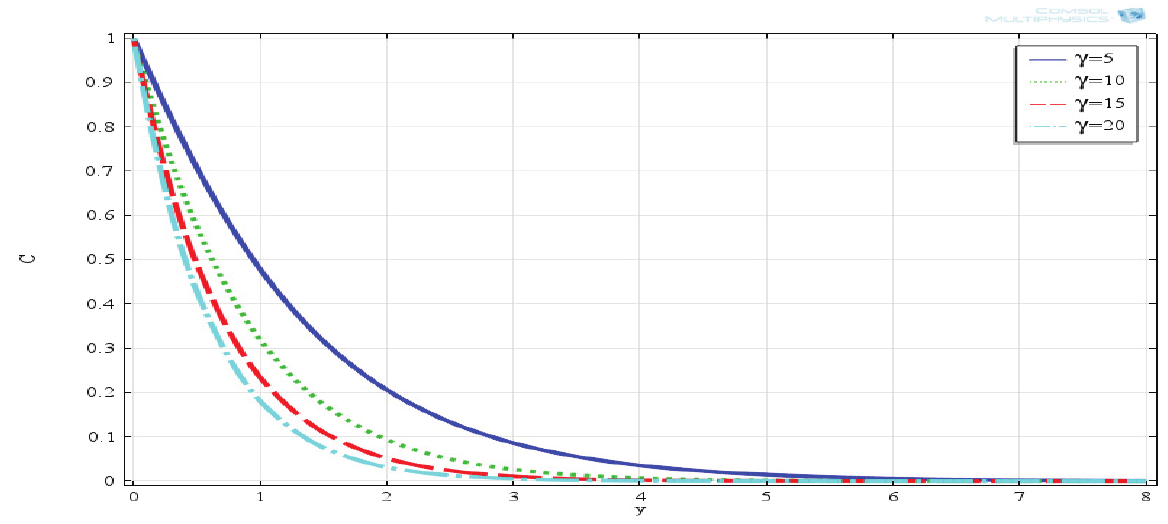
Figure 11: Steady state concentration profiles for different values of γ